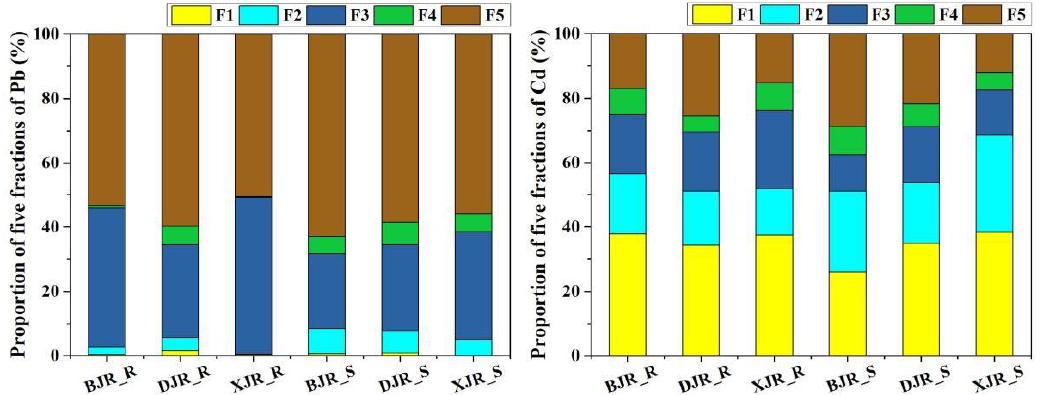
Figure 3. Proportion of five fractions of Pb and Cd in riparian soils and river sediments from three reaches.